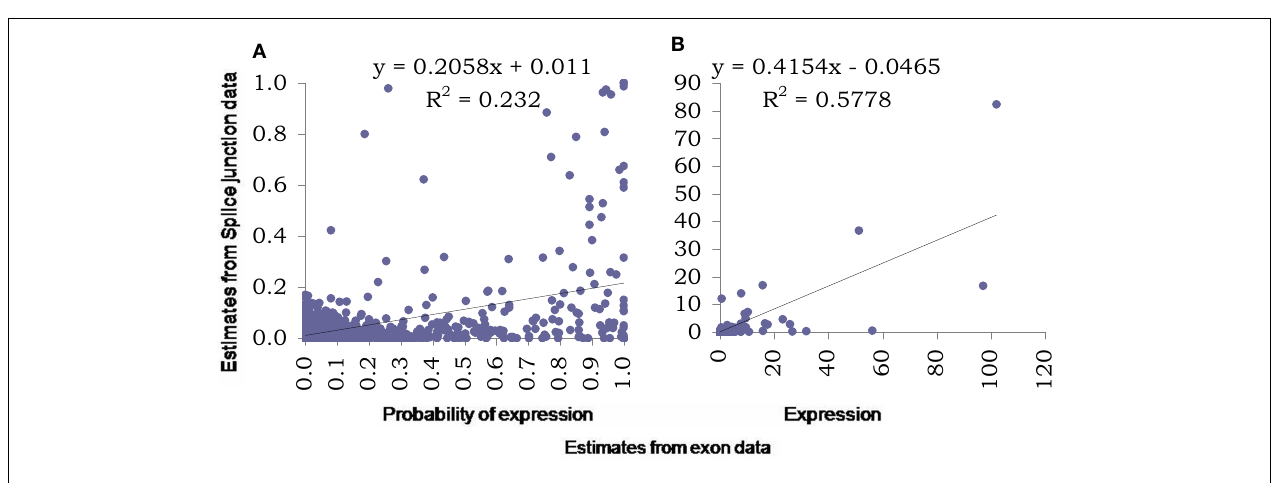
based on the two data types while the right panel (B) presents the estimated expressions at isoform level from the two data types. Both graphs also include fitted regression lines, corresponding equations and R 2